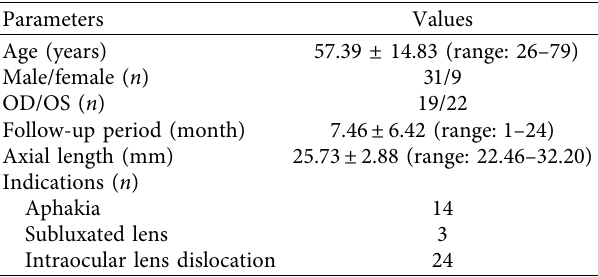
Table 1: Demographics of included patients.